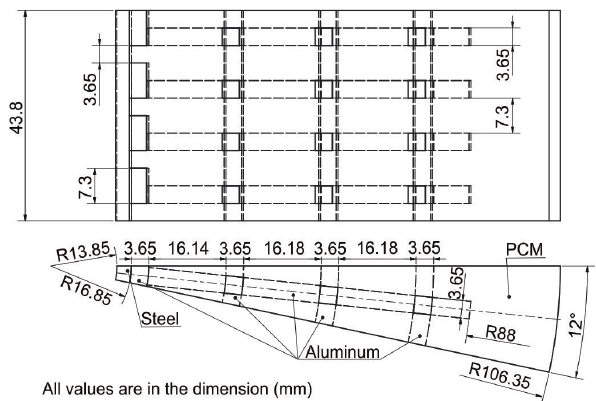
Figure 2. Computational domain and geometry data of the analyzed heat exchanger tube with wired matrix.